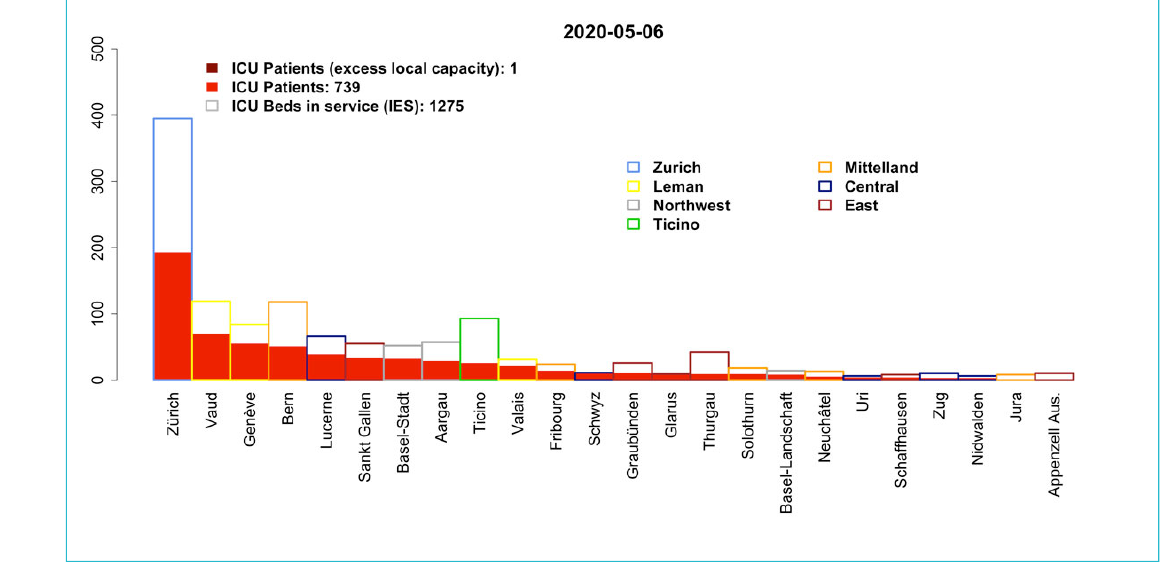
Figure 6: Projection for ICU bed occupancy on 06 May 2020 ranked by region and canton (model